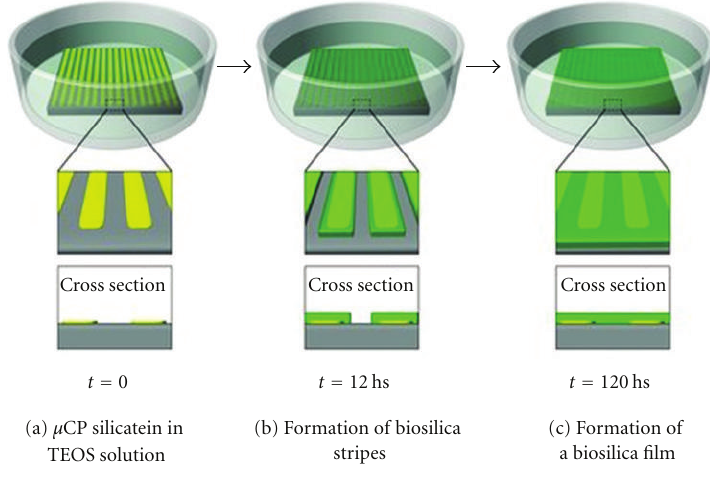
F 12: Formation of biosilica layers by controlling imprinting of silicatein. (a) Silicatein is microcontact printed onto the surface and the silica precursor TEOS is added. (b) Initially silica only covers the silicatein strips. (c) Over time the strips fuse to form a continuous layer or �lm. �eproduced with permission from